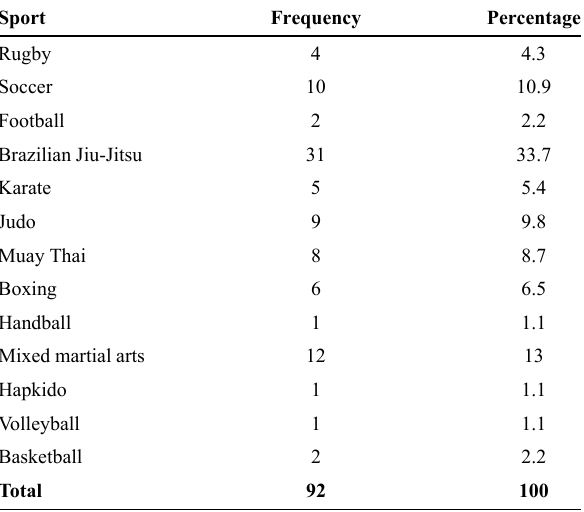
Table 7 - Distribution of athletes who reported orofacial trauma per